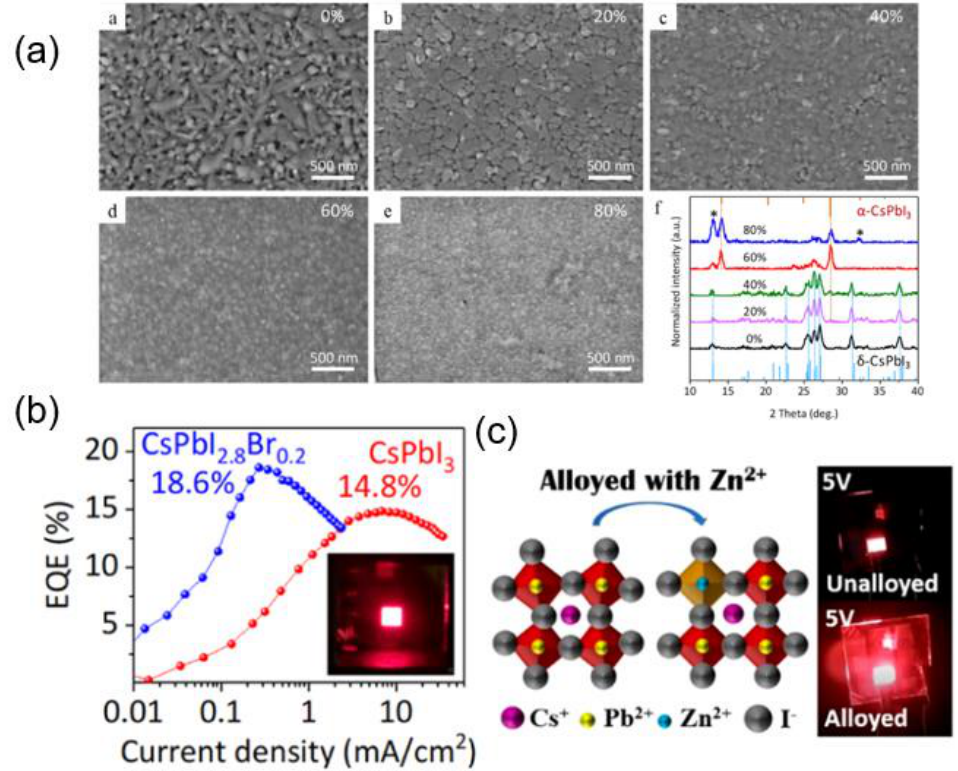
Figure 6. ( a ) SEM images and XRD patterns of CsPbI 3 films with different molar ratios of 4-F-PMAI. The peaks marked with “*” correspond to layered perovskites [56]. Copyright 2020 American Chemical Society. ( b ) External quantum efficiency and current density plots of CsPbI 2.8 Br 0.2 and CsPbI 3 [56]. Copyright 2020 American Chemical Society. ( c ) CsPbI 3 doping with Zn + [5]. Copyright 2019 American Chemical Society.